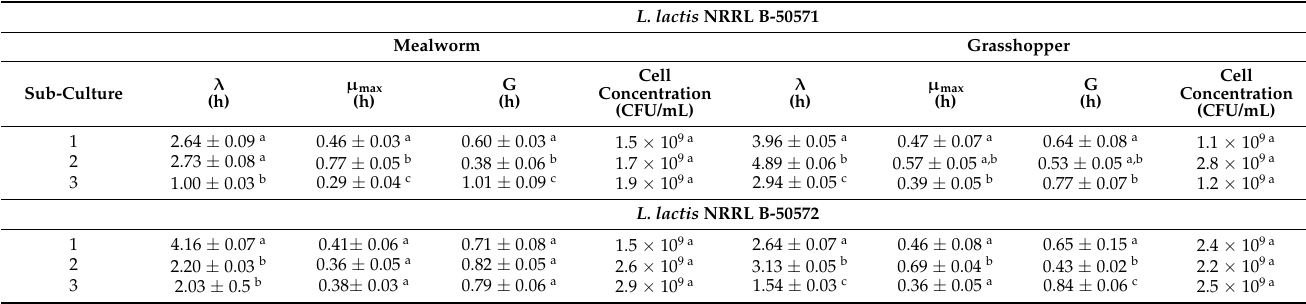
Table 2. The kinetic parameters obtained for the three subcultures of L. lactis . Mealworm Grasshopper